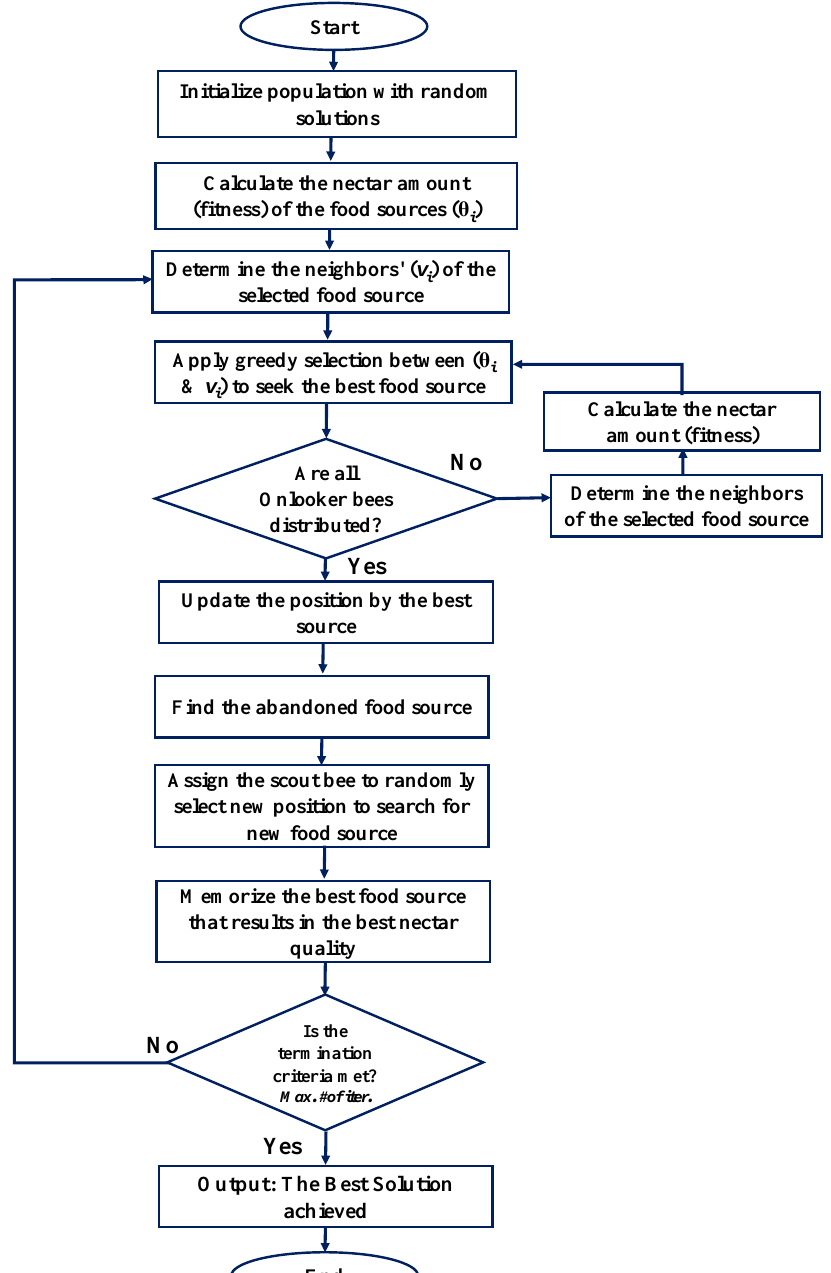
Figure 3. Flowchart of the Artificial Bees Colony (ABC)